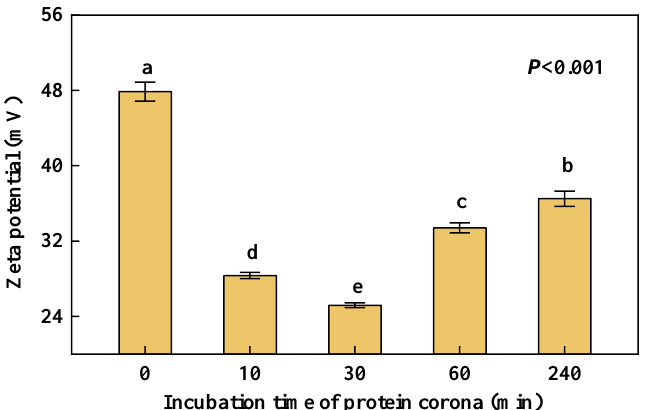
Figure 4. Zeta potential changes of PS NPs and the PC over time. Dates are means ± SE ( n = 3). Different letters indicate a significant difference at p < 0.05.